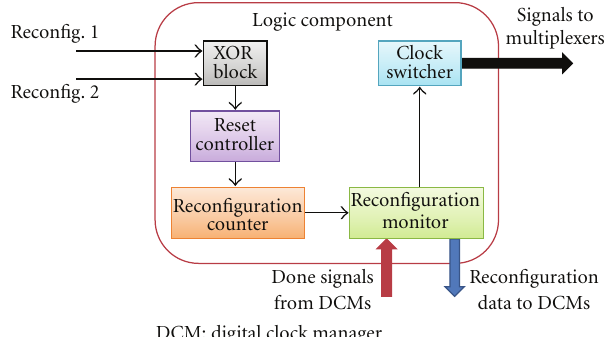
Figure 8: Internal structure of the logic block of the reconfigurable clock